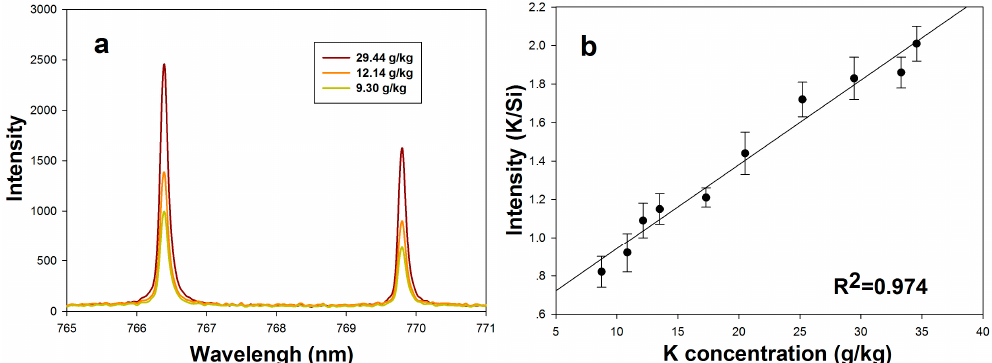
Figure 7. Determination of K in soil using LipsImag. ( a ) shows the spectral characteristics of K in soil; ( b ) is the calibration model for K concentration measurement .